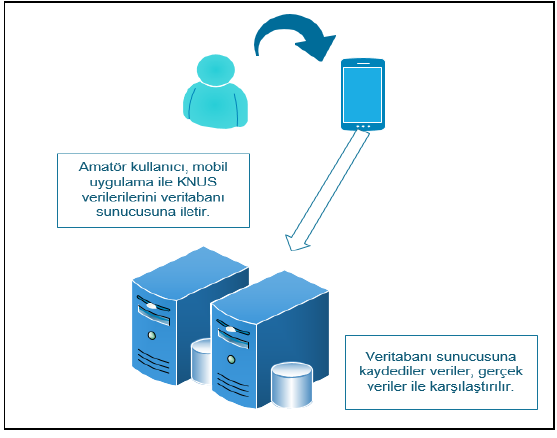
Figure 5. Block diagram of